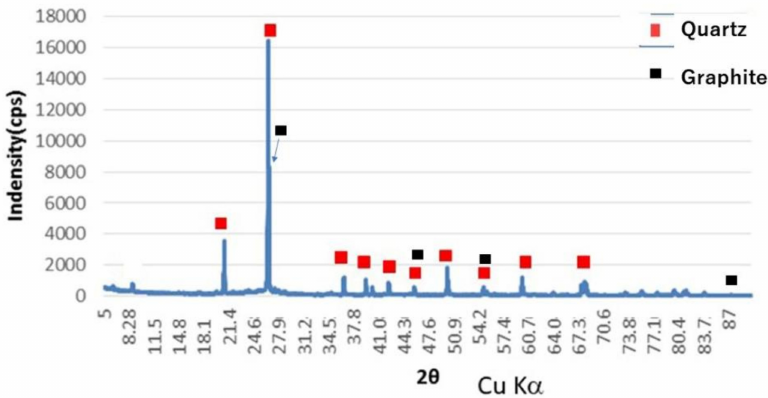
Figure 3. X-ray diffraction pattern of shungite